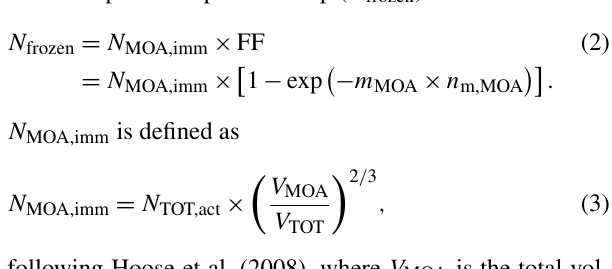
Figure 2. Ice-active site density per unit mass ( n m ) of the Wilson et al. (2015) parameterisation and of the fit to the DeMott et al. (2016) data, for marine aerosol, as well as the Niemand et al. (2012) parameterisation for dust aerosol. The Wilson et al. (2015) param- eterisation is converted from INP number per total organic carbon mass to INP number per MOA mass by dividing by the conversion factor of 1.9. The DeMott et al. (2016) fit and Niemand et al. (2012) parameterisation are converted from the original representation of ice-active site density per unit surface area ( n s ) by division by their respective density and multiplication by the spherical surface-to- volume ratio using the two extremes in accumulation-mode median radius in our model. The inverse dependence of the ratio on the radius induces higher ice activity of the smaller particle when con- verting from n s to n m . Solid lines represent the range in which the parameterisations are valid, and dotted lines represent temperature ranges where the parameterisations are linearly